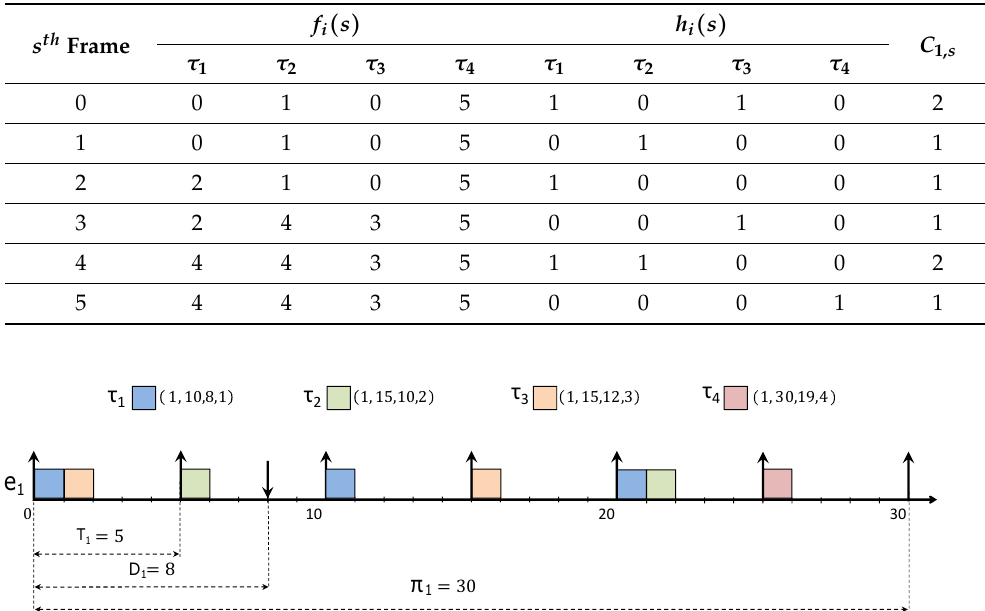
Table 3. An example of computing executor model parameters.